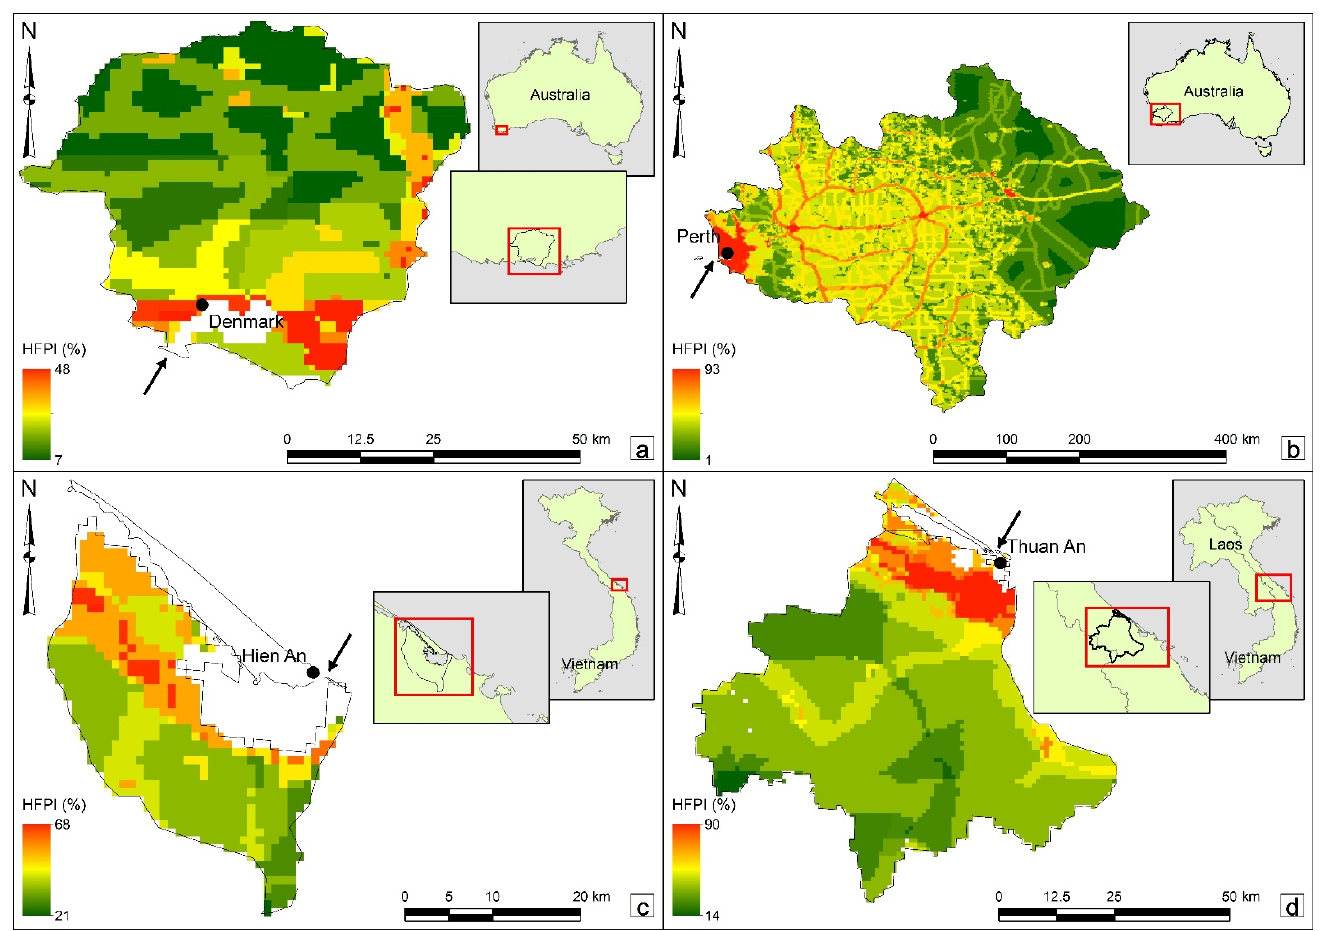
Figure 1. Human footprint index (HFPI) of the four systems considered; ( a ) Wilson Inlet system, Australia; ( b ) Swan River system, Australia; ( c ) Tu Hien Inlet system, Vietnam and ( d ) Thuan An Inlet system, Vietnam. Arrows indicate the locations of the inlets.